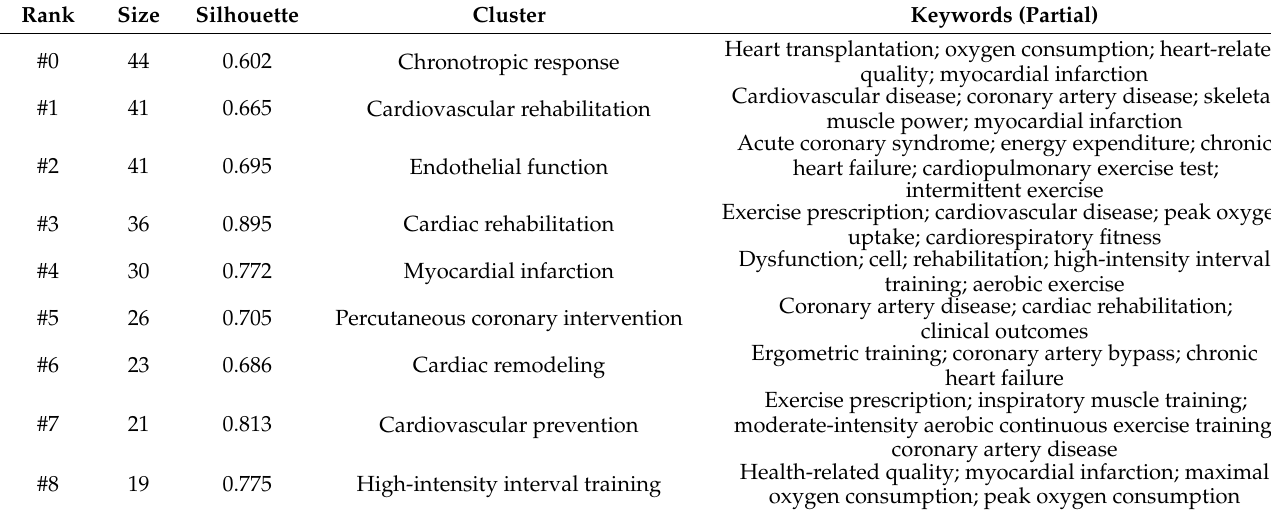
Figure 6. Keyword clustering and visual time-zone mapping. Table 7. List of keyword clusters.